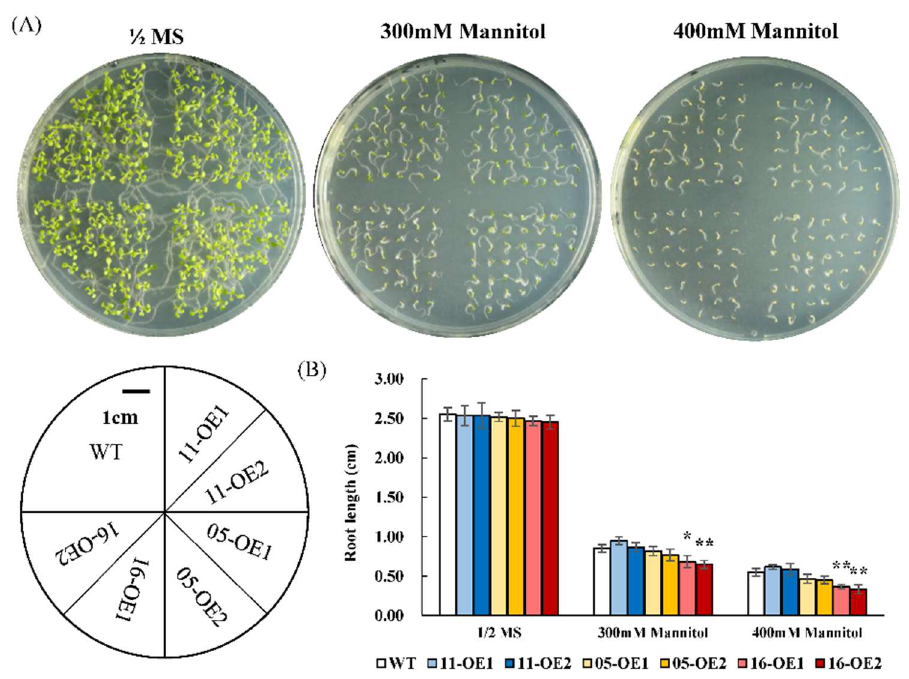
Figure 5. Analysis of drought tolerance at seed germination stage. ( A ) Morphology of WT and transgenic seeds germinated for 8 days on half-strength MS medium with 0, 300, or 400 mM mannitol. Below, the distribution diagram for the WT and transgenic lines on the culture plate is shown. Bars = 1 cm. ( B ) Root length of 8 day old WT, 11-OE1/OE2, 05-OE1/OE2, and 16-OE1/OE2 plants. Data are presented as means and standard deviations of three independent experiments. Asterisks indicate statistical difference (* p < 0.05, ** p < 0.01) compared to WT. In the adult stage (1 month old), there were no clear phenotypic differences between transgenic plants and the WT. After drought treatment for 15 days, all plants showed growth inhibition and chlorosis and the 16-OEs showed the least vigor. Most AhMYB44s transgenic plants failed to survive after re-watering for 7 days, whereas 11-OEs showed higher survival rates than the WT (Figure 7A). In addition, we measured the levels of drought-resistance indicators (proline, soluble sugar, and chlorophyll) in WT and transgenic plants. There were no significant differences in these indicators among all experimental samples under normal conditions. After drought treatment, 11-OEs demonstrated higher proline, soluble sugar, and chlorophyll levels than the WT, while 16-OEs showed the opposite trend (Figure 7B–D). In summary, overexpression of AhMYB44-16 significantly increased drought sensitivity, and overexpression of AhMYB44-11 may lead to improve drought tolerance in transgenic plants. The 05-OEs, however, displayed no significant differences compared to the WT under drought